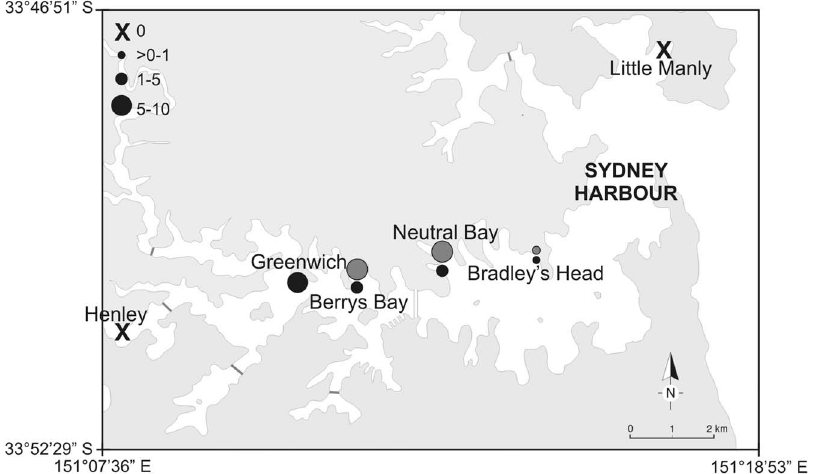
Figure 3. Distribution along Sydney Harbour. Mean densities of Cirolana harfordi (ind/100 ml of sample) in oyster-beds in Sydney Harbour. Berrys Bay, Neutral Bay and Bradley’s Head were sampled in June (grey) and October (black) 2010. Henley, Greenwich and Little Manly were sampled only in October 2010 (see methods). There were no C. harfordi individuals found at Henley and Little Manly.